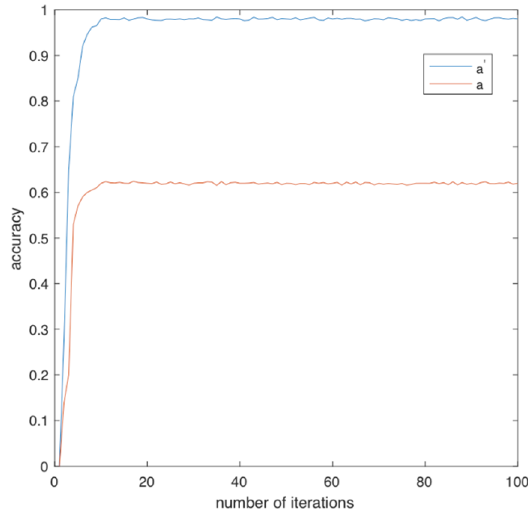
Figure 3. Accuracies a and a (cid:48) .